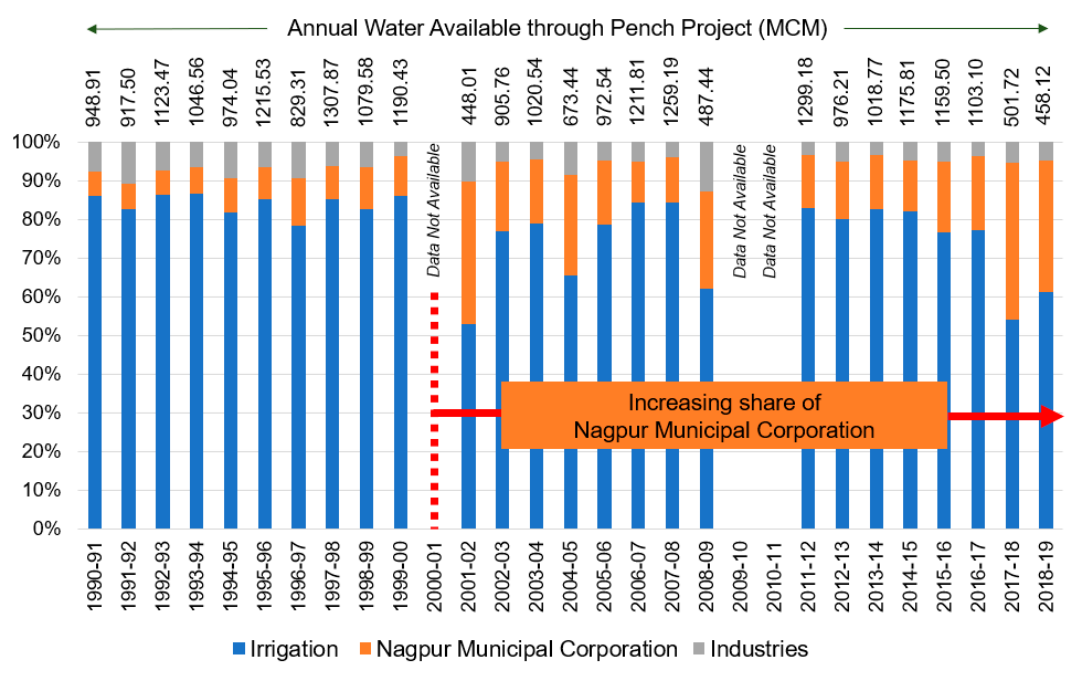
Figure 6. Annual water-utilization trends from the Pench Irrigation Project (1990 to 2019). Information source: References [109,110].